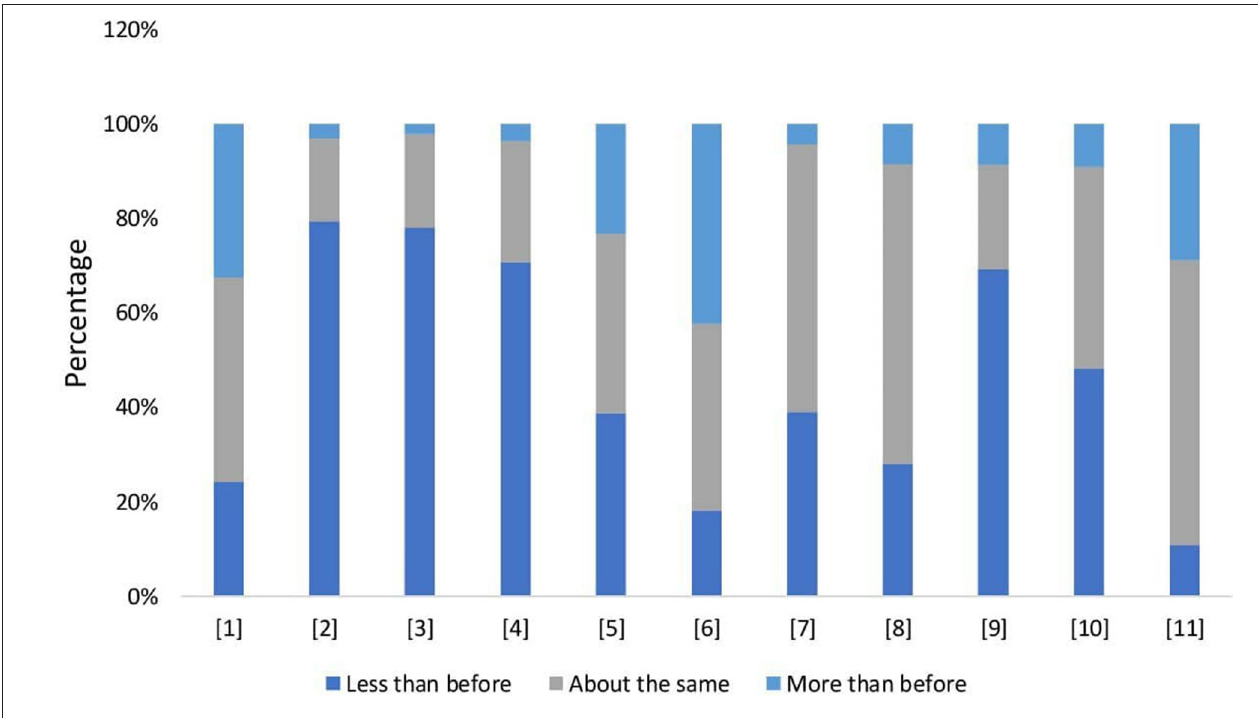
FIGURE 2 | Changes of food-related behaviors during COVID-19 pandemic ( n =